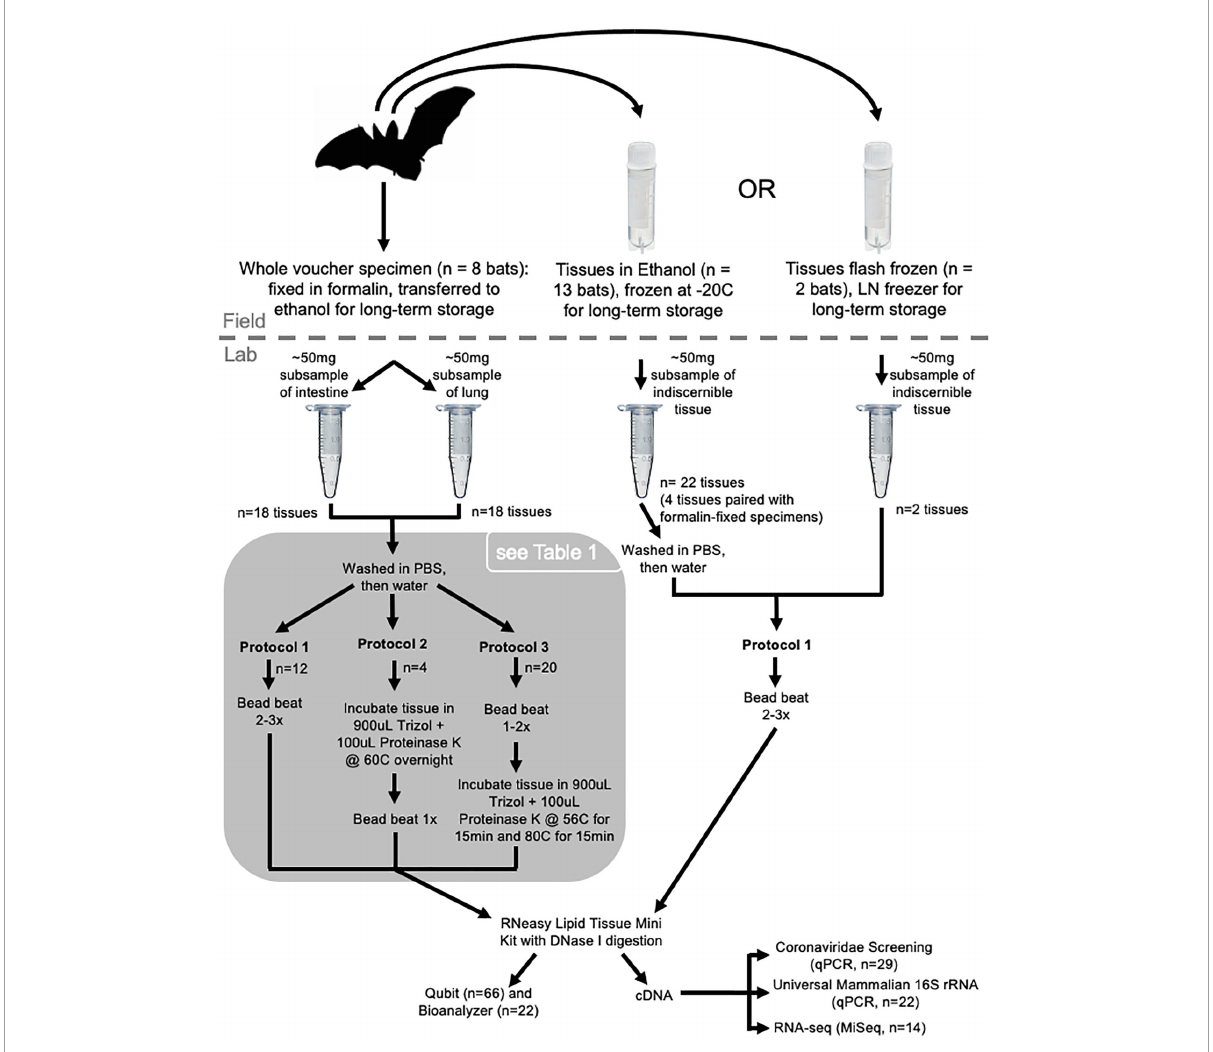
FIGURE1 Sampling and processing design. Whole voucher specimens collected in 1886 and 1888 ( n = 3 bats, n = 6 tissues; ethanol-RT) are not shown in the